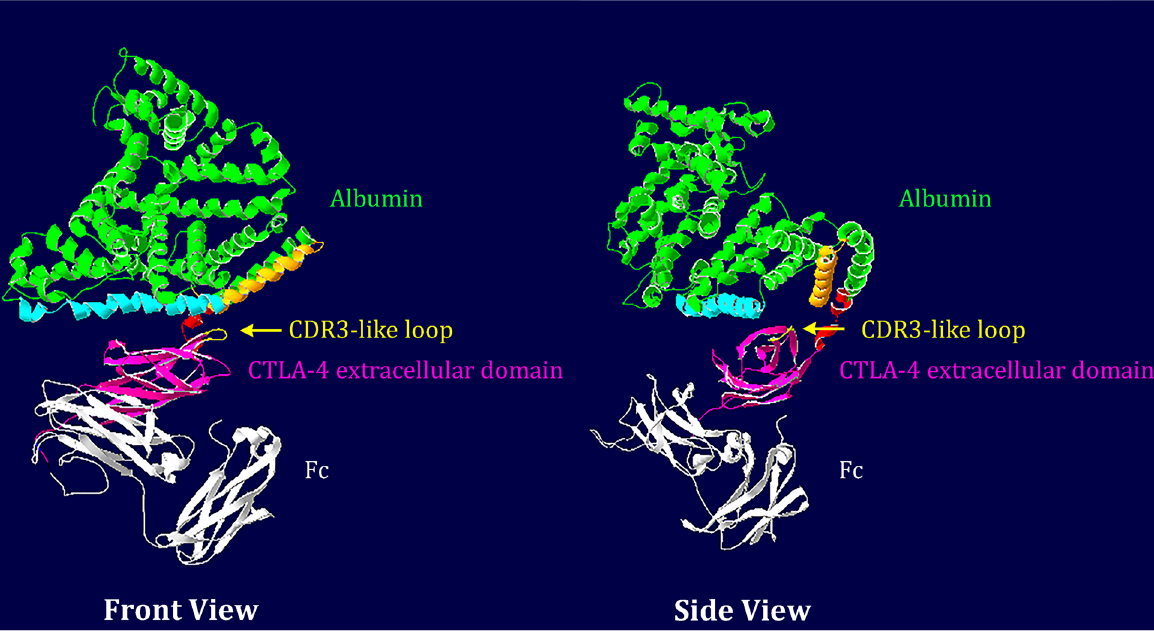
Fig. 5 Structure simulation of mouse Alb‑CTLA4Ig. The protein sequences of mAlb‑CTLA4Ig were input into the online server ROBETTA for structure prediction. Shown here are the front view and the side view (rotated 90°) of the predicted structure of the fusion protein where albumin is represented in green, the extracellular domain of mouse CTLA4 is represented in magenta, the mouse Ig domain is represented in white, and the MMP substrate sequence is represented in red. Note that the CDR3‑like loop is blocked by helix h4 (light blue) of domain IIb and helix h3 (orange) of domain